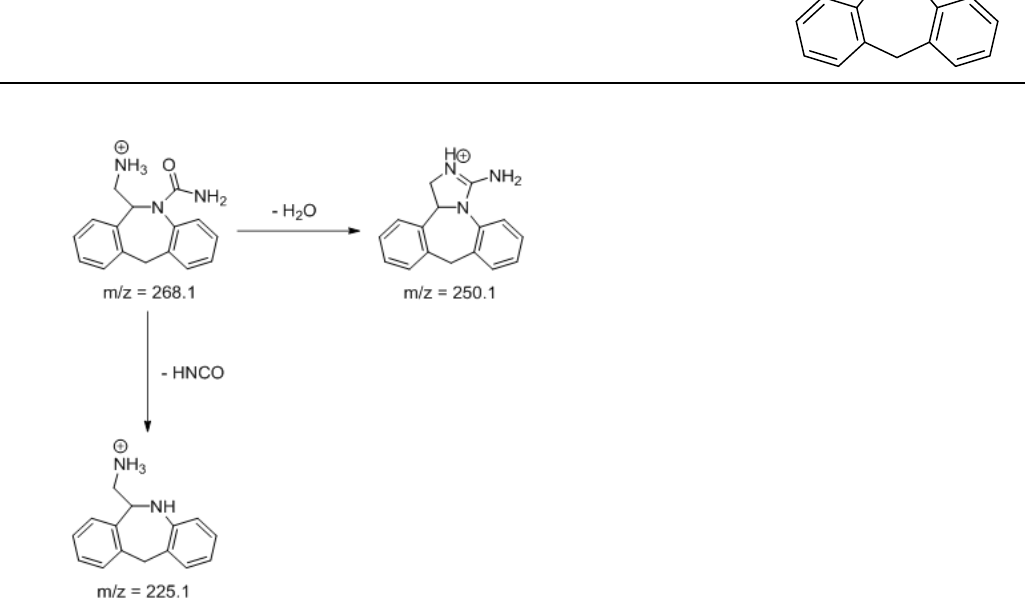
Figure 9. Fragmentation pattern of epinastine (EPI) degradation product EPI-DP1.